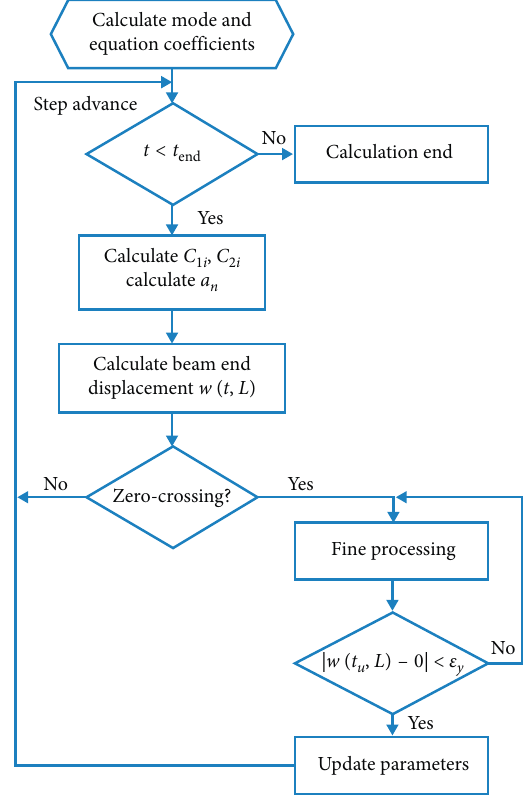
Figure 4: Flow chart of solving process. Table 1: System